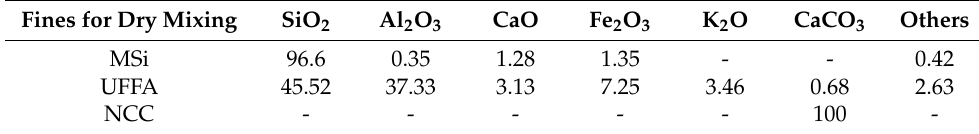
Table 1. Detailed compositions of the fine particles used for dry mixing (%). Fines for Dry